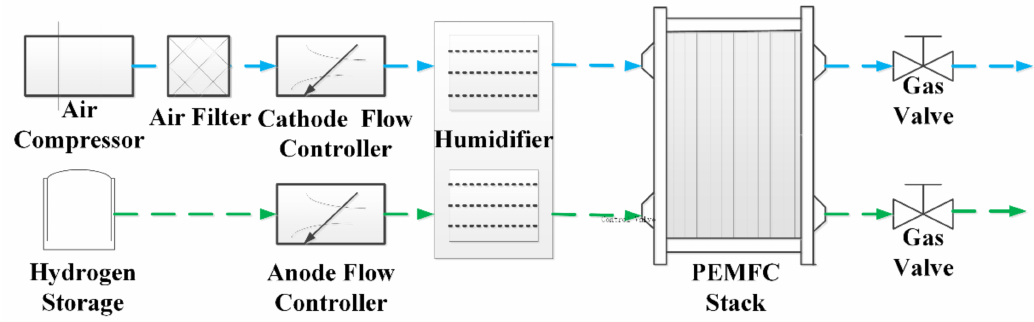
Figure 1. Proton exchange membrane fuel cell (PEMFC) gas supply system